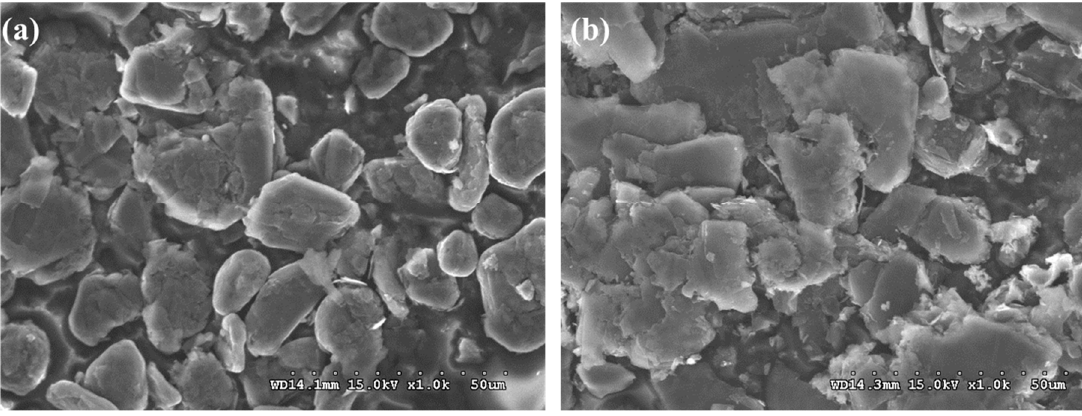
Figure 8. SEM images of ( a ) pristine and ( b ) postcycled natural graphite.